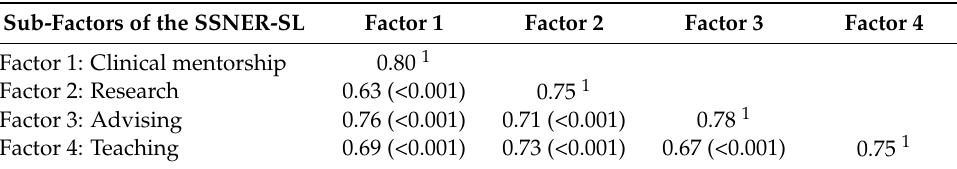
Table 6. Correlation matrix and the square root of average variance extracted for discriminant validity of SSNER-SL ( n =